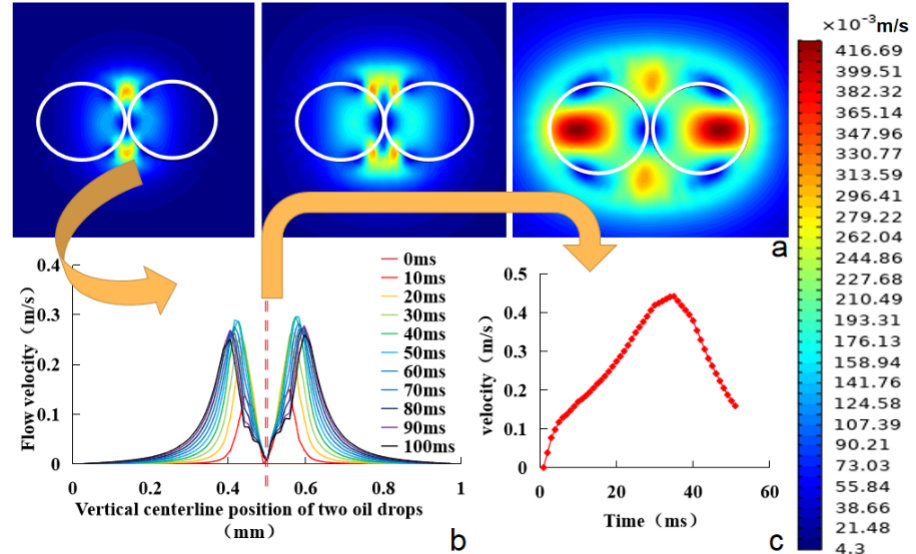
Figure 4. The variation of fluid velocity with time at a vertical position in the system. ( a ) Variation of velocity field in oil droplet coalescence system. ( b ) Velocity variation of vertical centerline of oil droplet coalescence system. ( c ) Velocity variation at the midpoint of the system during oil droplet coalescence.